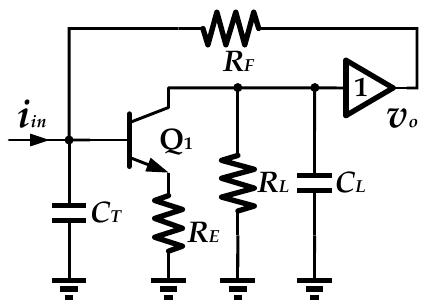
Figure 3. The simplified small-signal equivalent circuit of the input TIA.